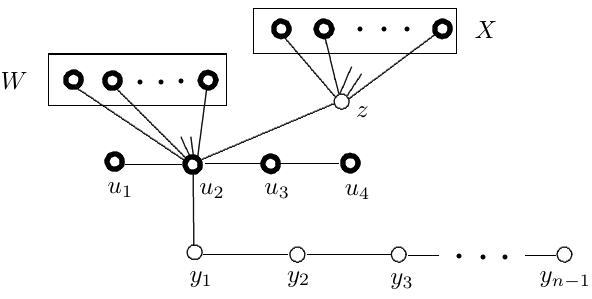
Figure 2: The graph G in the proof of Case 2 of Theorem